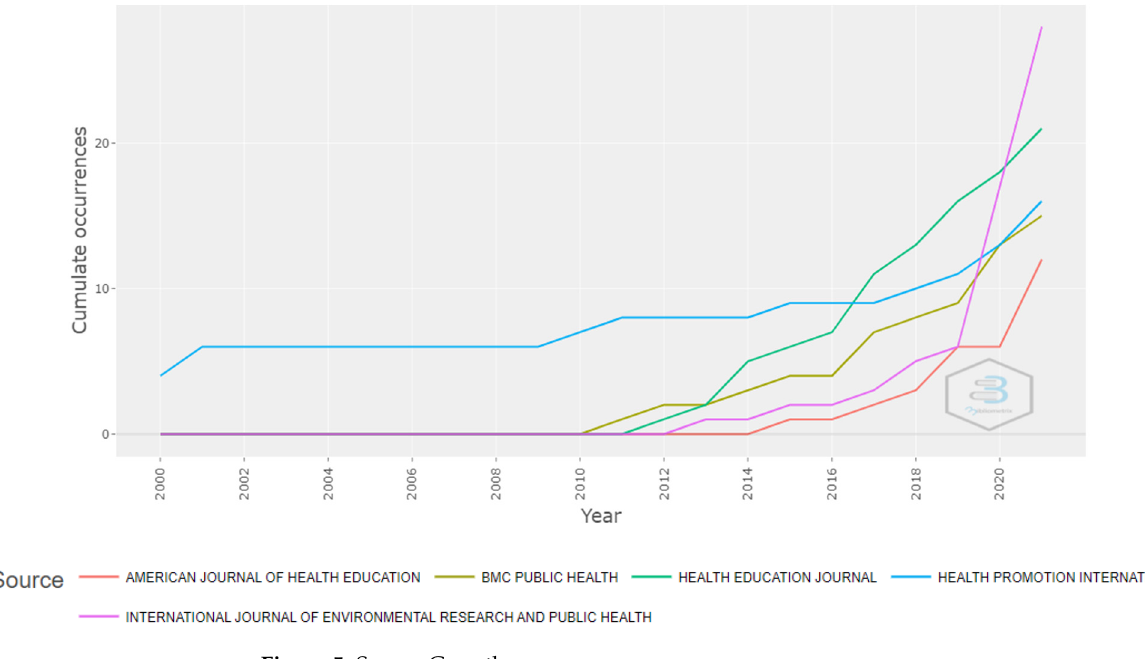
Table 4. Characteristics of the five journals with the most publications in the Web of Science Core